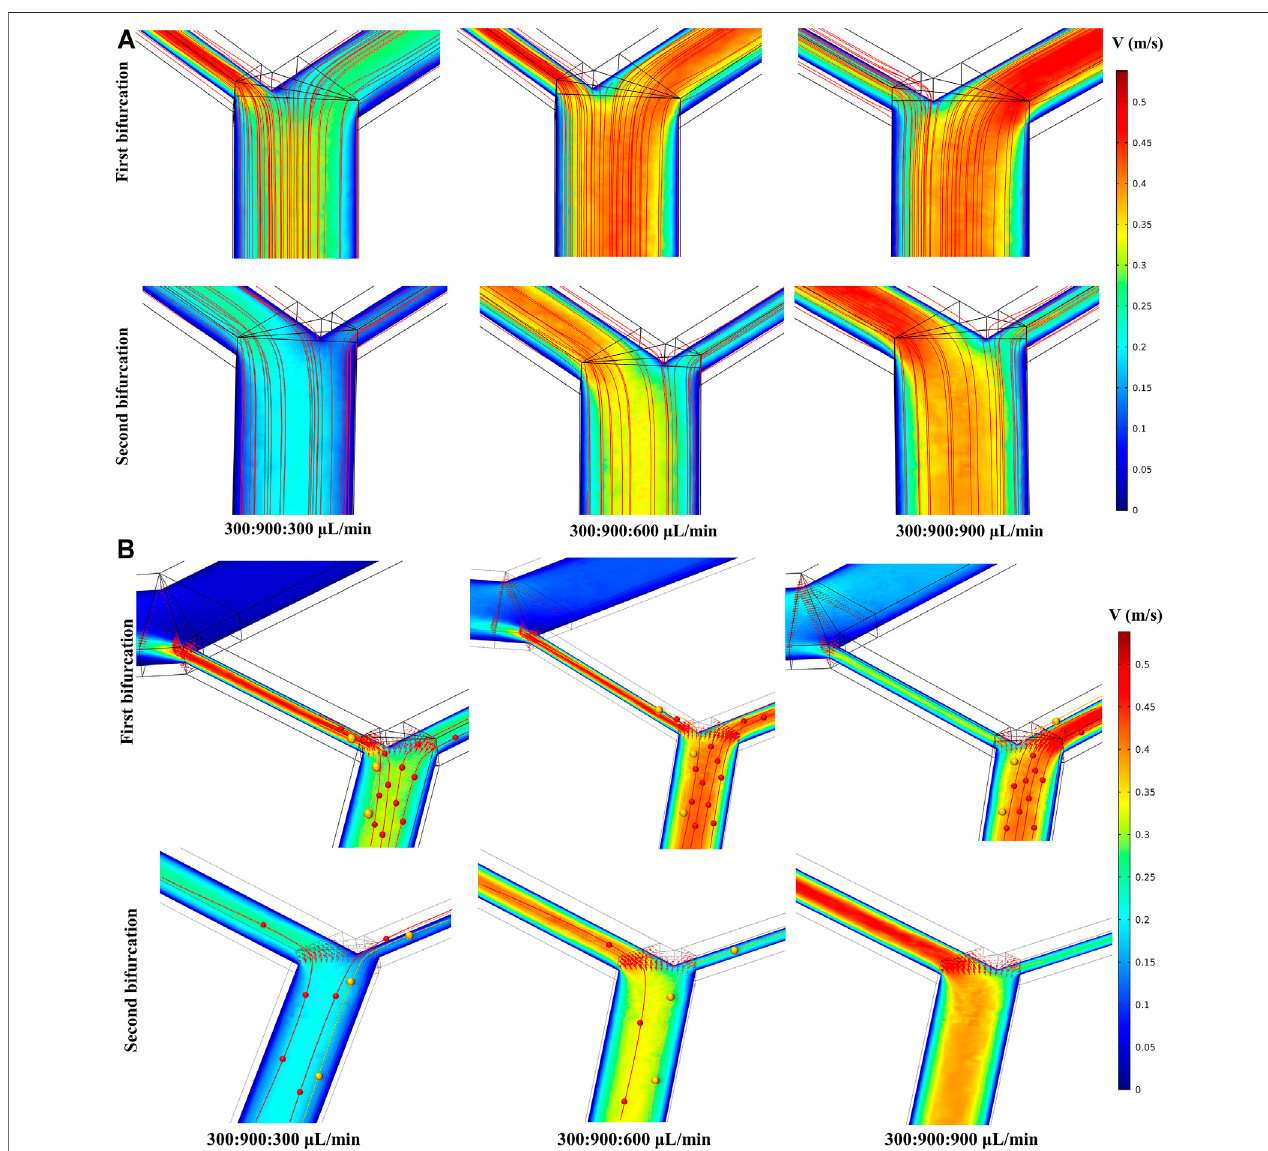
FIGURE2| Simulation results at two bifurcations. The fl owratio at thebottom ofthe image corresponds tosample:1stsheath:2ndsheath. (A) The in fl uence ofthe 2nd sheath fl ow rate on the both velocity and fl uid streamline distribution at the two bifurcations. (B) Particle trajectories were drawn on the simulation of velocity distribution. Different sized particles moved toward different